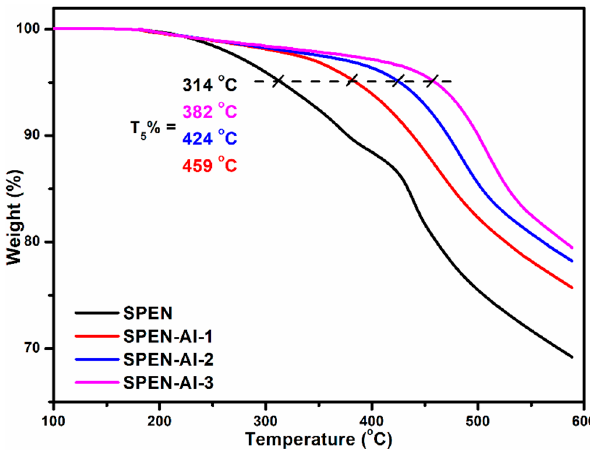
Figure 3. TGA curves of raw SPEN and SPEN-Al induced by Al 3+ in different concentrations.